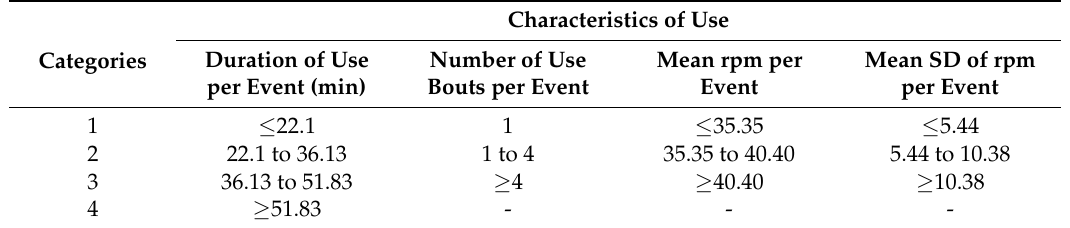
Table 2. Categories of characteristics of use; rpm = rounds per minute; SD = Standard Deviation. Characteristics of Use Duration of Categories